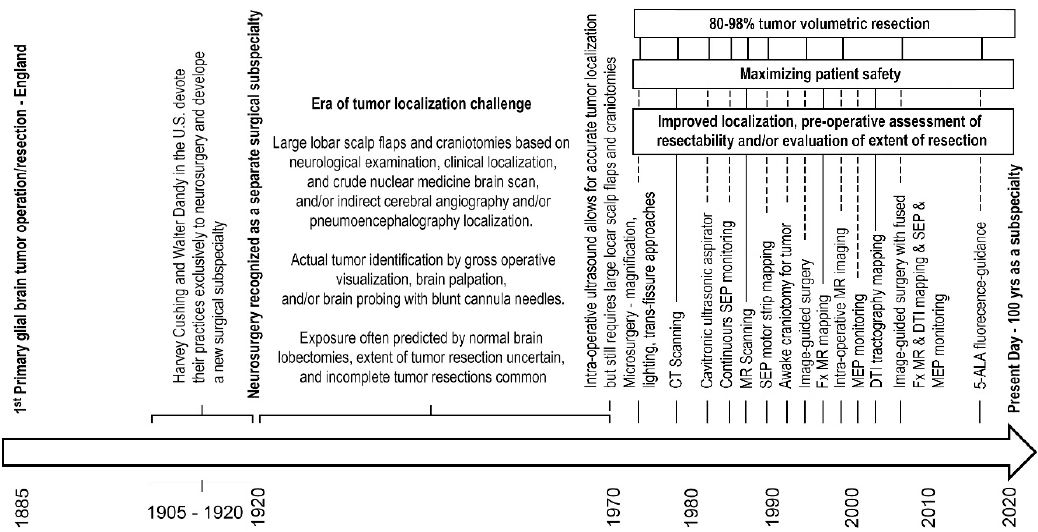
Figure 1. Surgical advances for gliomas timeline. Lists of abbreviations: 5-ALA, 5-aminolevulinic acid; CT, computerized tomography; DTI, diffusion tensor imaging; Fx, functional; MR, magnetic resonance; MEP, motor evoked potential; SEP, somatosensory evoked potential.